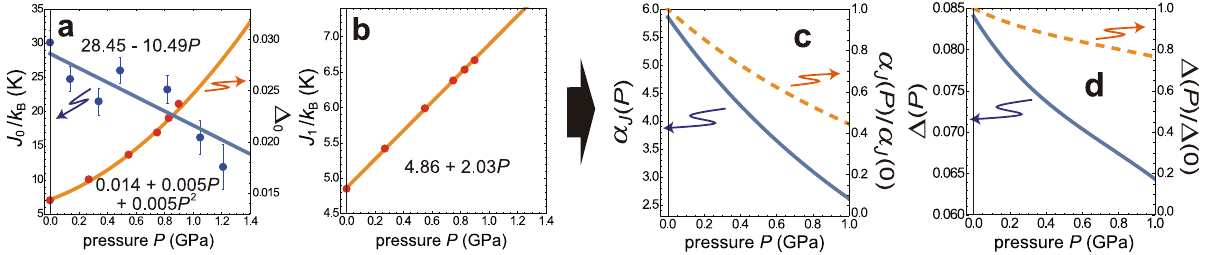
Fig. 5 Pressure dependence of the coupling parameters in CsCuCl 3 . a The estimated values of the intrachain coupling constant J 0 and the anisotropy parameter Δ 0 . b The estimated values of the intrerchain coupling constant J 1 . The error bars re fl ect six standard deviations for J 0 and are smaller than the symbol size in the min-max values for Δ 0 and J 1 . The model functions for each quantity, J 0 ( P ), Δ 0 ( P ), and J 1 ( P ), are shown by the solid curves. c , d The ratio of the intrachain to interchain coupling, α J ( P ) = J 0 ( P )/ J 1 ( P ), and the rescaled anisotropy parameter Δ ( P ) = α J ( P ) Δ 0 ( P ). The reduction rate from the value at P = 0 is plotted for each with the dashed